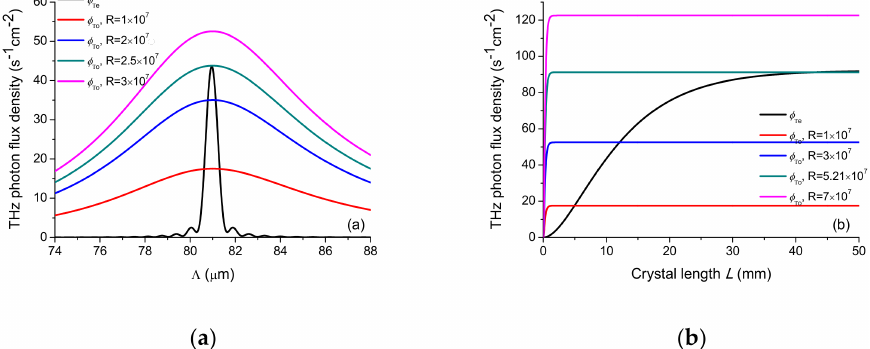
Figure 6. THz wave photon flux density φ T for the backward SPS processes. Λ p = 1550 nm, ν Te = 0.52 THz, ν To = 2.06 THz, I p = 100 MW/cm 2 , and φ se ( 0 ) = 10 6 s − 1 cm − 2 . ( a ) φ T versus Λ from 74 to 88 µ m. L = 10 mm. ( b ) φ T versus crystal length L . Λ = 80.978 µ